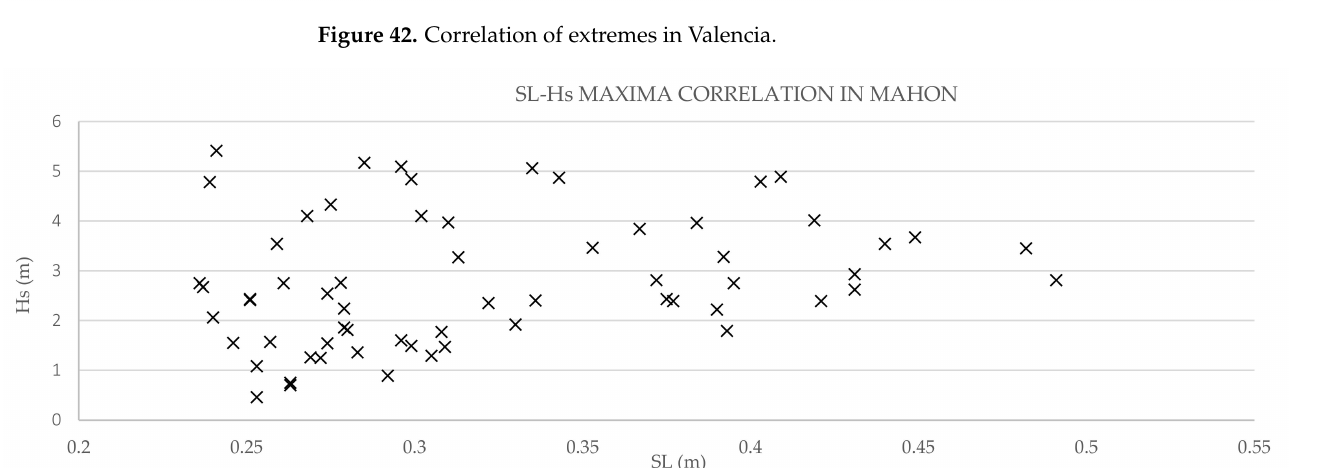
Figure 43. Correlation of extremes in